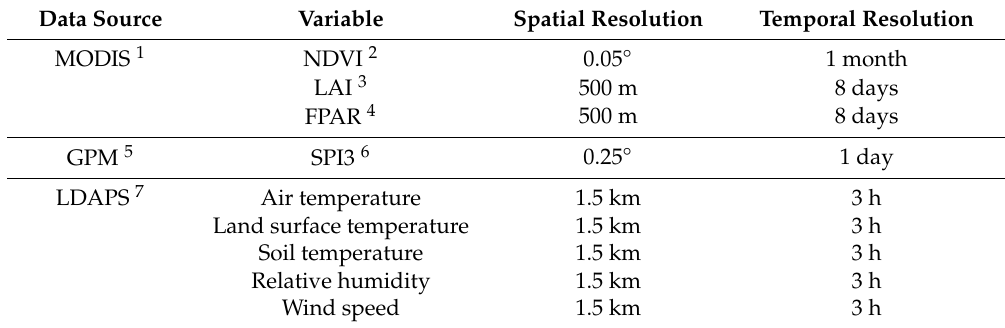
Table 1. Spatial and temporal resolutions of the data used as input features for the ML-based ET 0